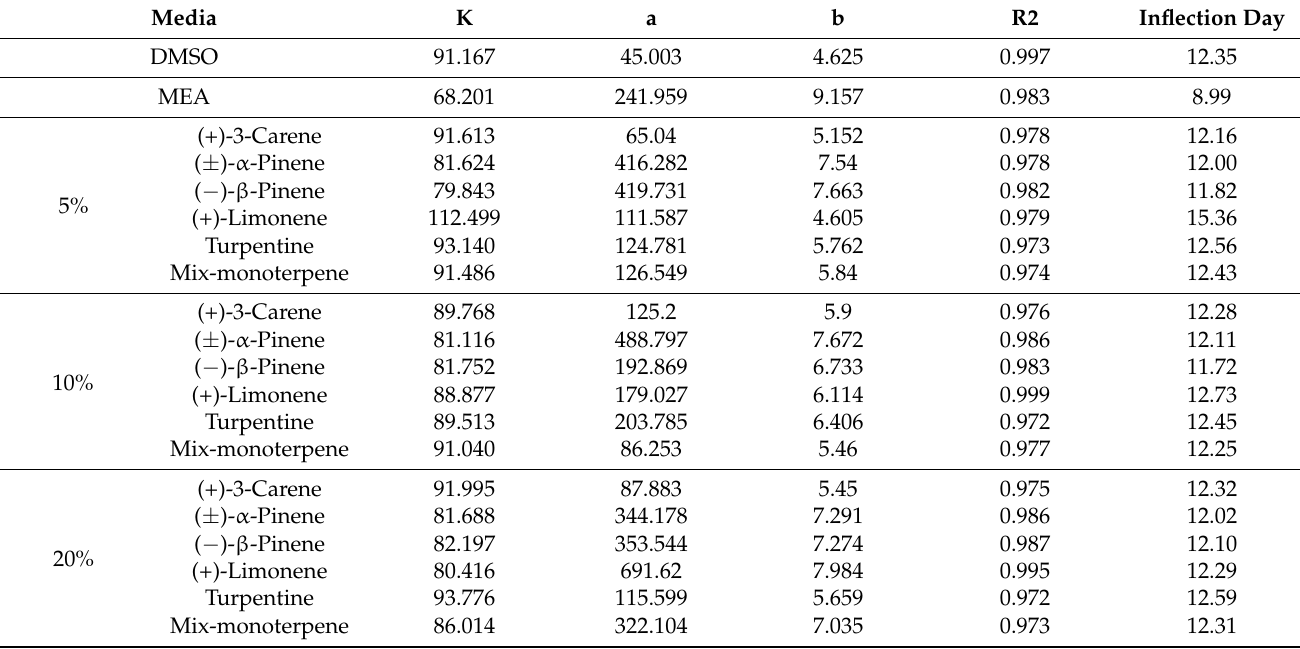
Table 5. Growth curve of L. qinlingensis in different terpenoid treatments after logistic curve fitting.